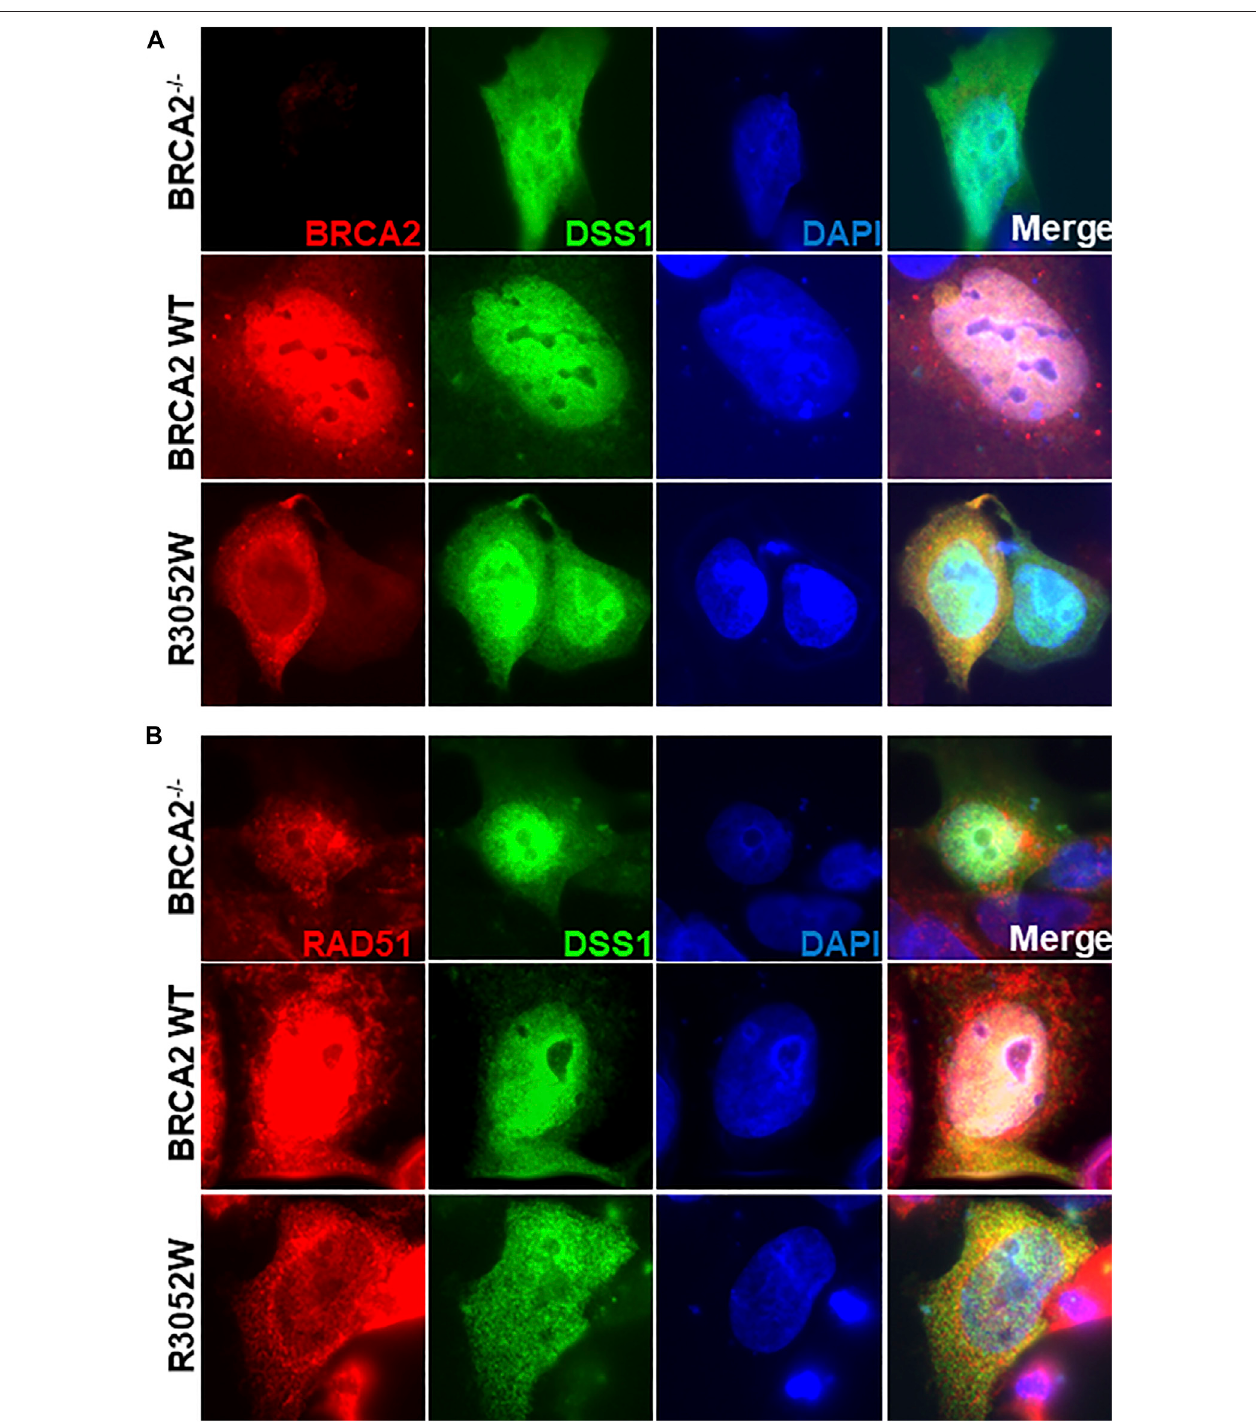
FIGURE 5 | Ectopic expression of DSS1 does not alter BRCA2 WT, R3052W or RAD51 cellular localization. (A) Immuno fl uorescent localization of BRCA2 and DSS1 in untreated BRCA2 knockout cells stably expressing WT BRCA2 or the R3052W mutant concurrent with transient expression of HA-DSS1. Representative imagesofBRCA2(red,MBPantibody),DSS1(green,HAantibody)andDAPIstainingtovisualizenuclei(blue). (B) Immuno fl uorescentlocalizationofRAD51andDSS1in untreated BRCA2 knockout cells stably expressing WT BRCA2 or the R3052W mutant concurrent with transient expression of HA-DSS1. Representative images of RAD51 (red, RAD51 antibody), DSS1 (green, HA antibody), and DAPI staining to visualize nuclei (blue).